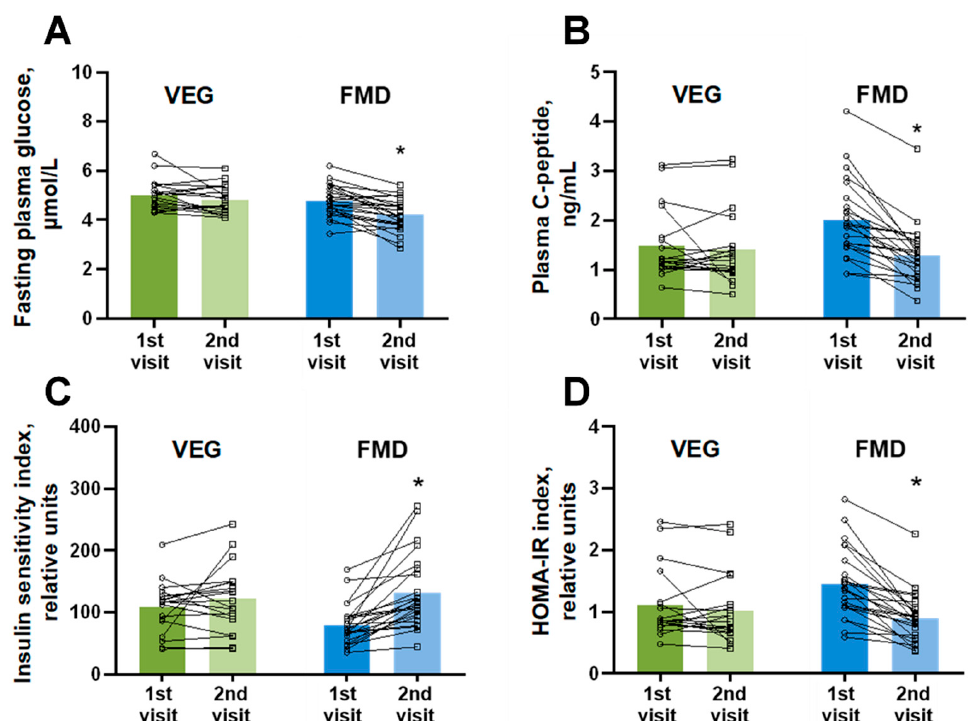
Figure 5. Changes in fasting plasma glucose levels ( A ), plasma C-peptide levels ( B ), insulin sensitivity index ( C ), and HOMA-IR index ( D ) after the 5-day cycle of regular diet supplemented with additional vegetables (VEG) and fasting-mimicking diet (FMD). The results are presented as the mean and independent values of 19 volunteers in the VEG group and 24 volunteers in the FMD group. * Indicates a significant difference from the respective group at the 1st visit (Wilcoxon matched-pairs test), p < 0.05.